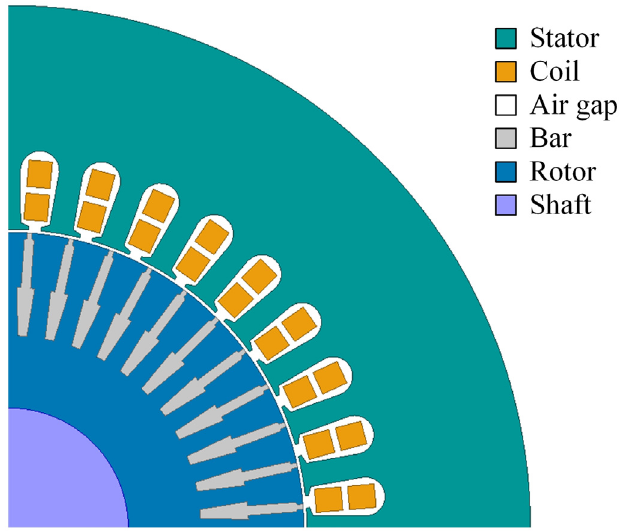
Fig. 7. Schematic diagram of the two-dimensional cross-section of the motor.